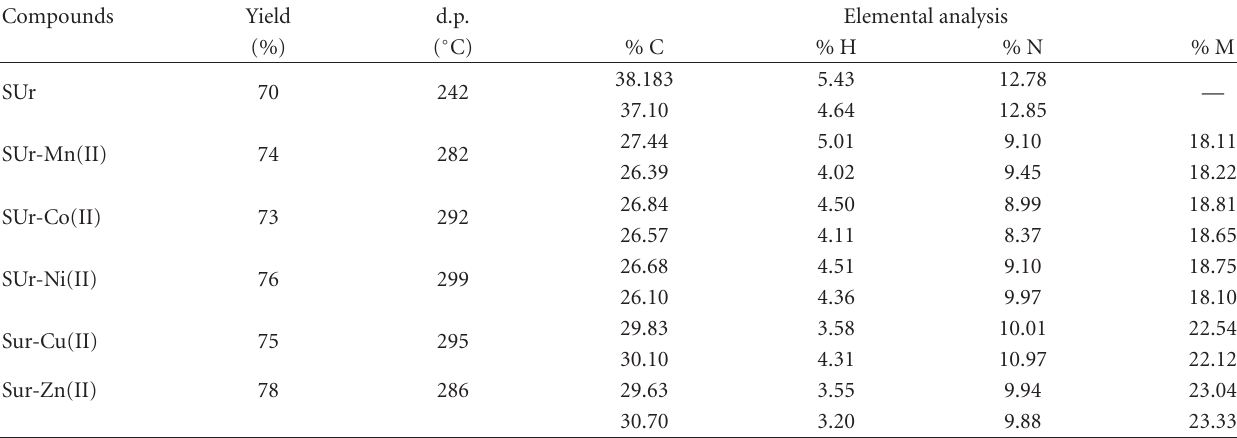
Table 1: Elemental analysis and yields of the synthesized polymeric compounds.